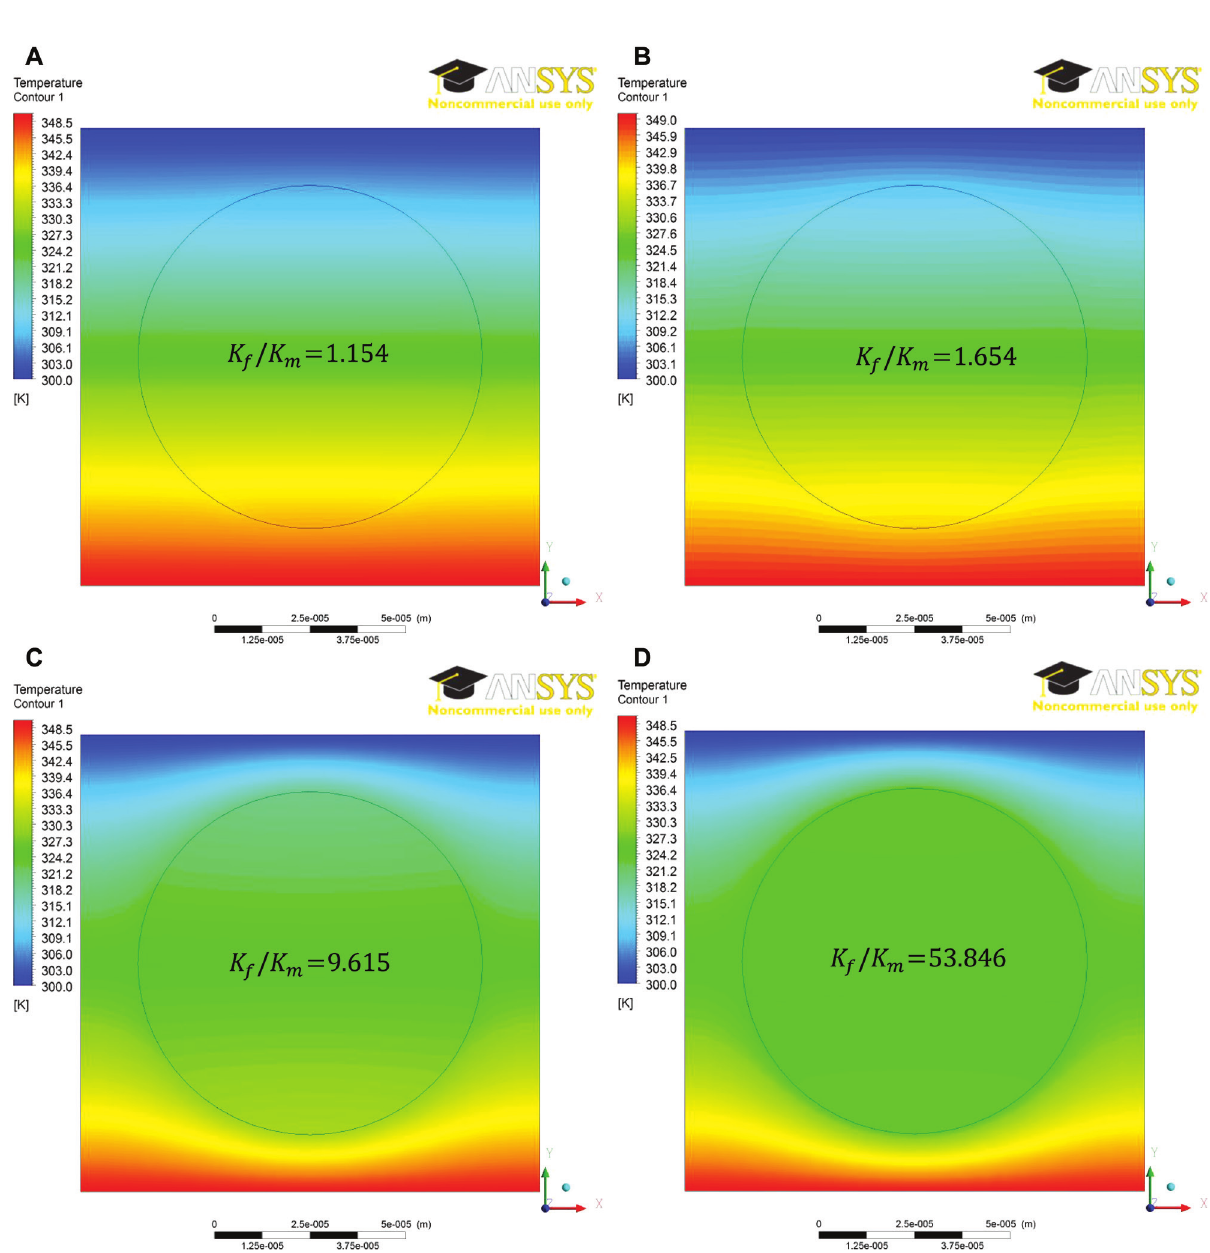
= 0.442, Δ T = 50 K: (A) cotton/air, (B) glass fibre/air, (C) nylon6/air f